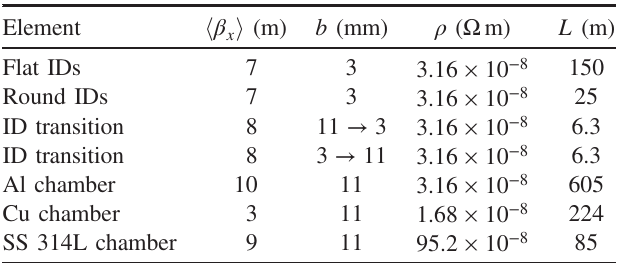
TABLE I. Resistive wall impedance elements.